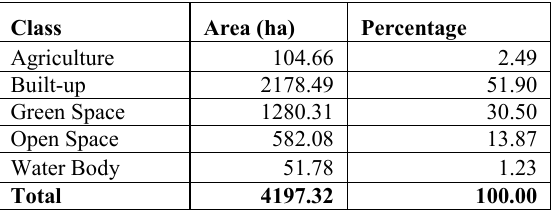
Table 2: Area of LULC for the